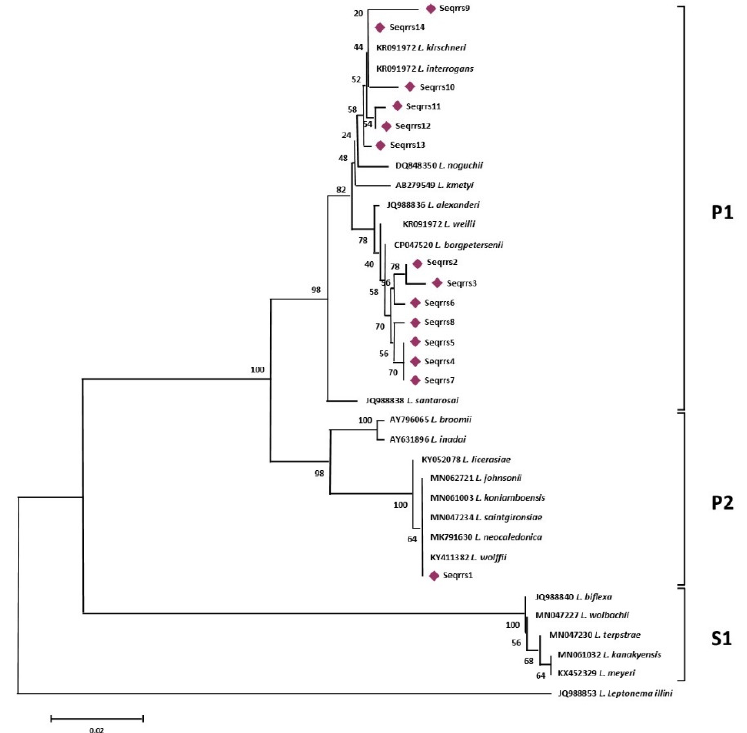
Figure 1. rrs -based phylogenetic analyses of the sequence types generated in this study and of 22 sequences representative of the different species of the genus Leptospira . Evolutionary history was inferred using the Neighbor-Joining method. The optimal tree with the sum of branch length = 0.41105704 is shown. The percentage of replicate trees in which the associated taxa clustered together in the bootstrap test (1000 replicates) are shown next to the branches.